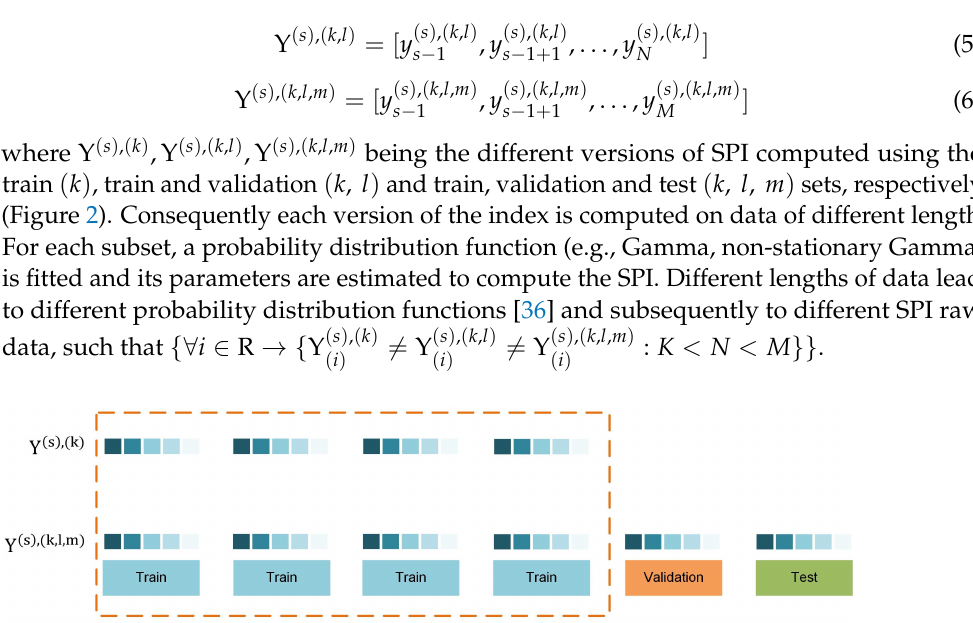
Figure 2. Calculation of the SPI using different subsets of the data within time series